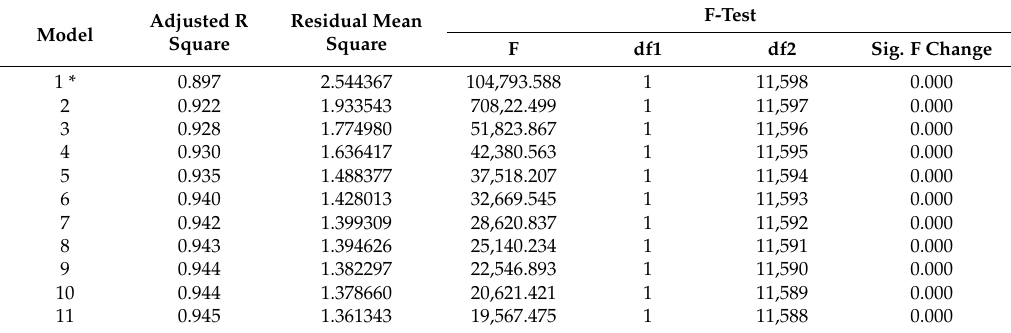
Table A2. Stepwise regression analysis for predicting the specific air humidity ( Q a ).